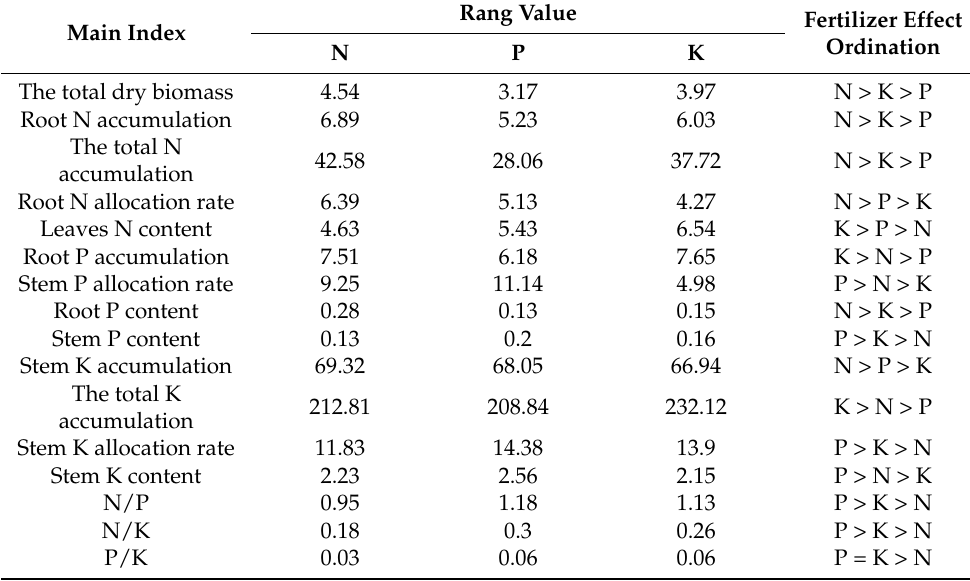
Table 11. Range analysis of effect of N-P-K fertilization on main indexes of P. bournei